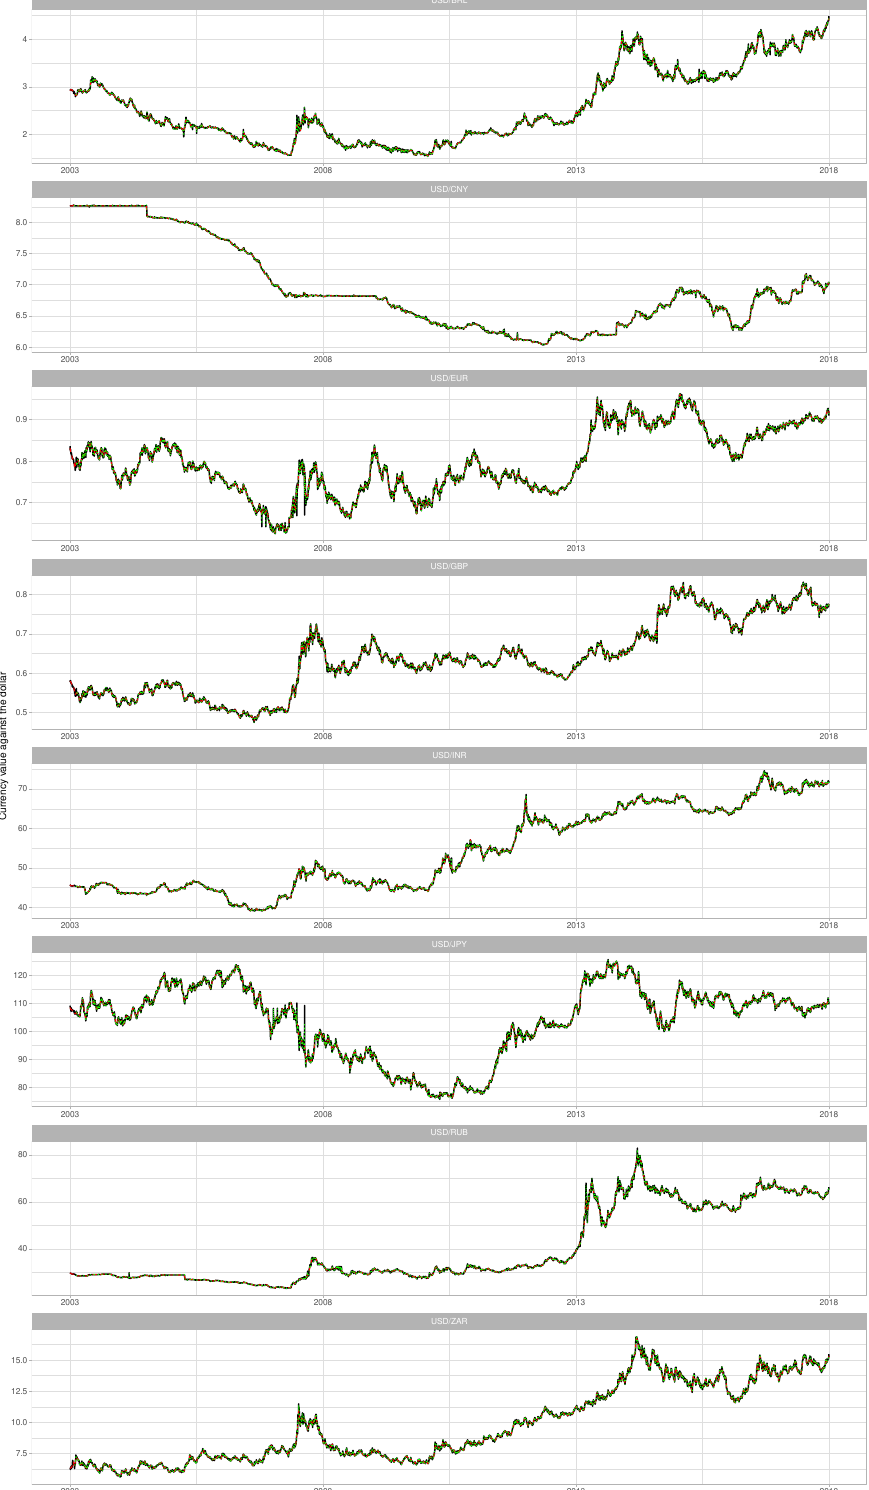
Figure 4. Original time series (black line), smoothed time series after applying the SSA considering a window length L p and r p eigentriples (Table 3) (red line) and model fit by the hybrid algorithm that combines the SSA and the ANN (green line), for each of the eight currency exchange rates. From top to bottom: USD/BRL, USD/CNY, USD/EUR, USD/GBP, USD/INR, USD/JPY, USD/RUB, and USD/ZAR. The vertical axes show the exchange rate and the horizontal axes shows the